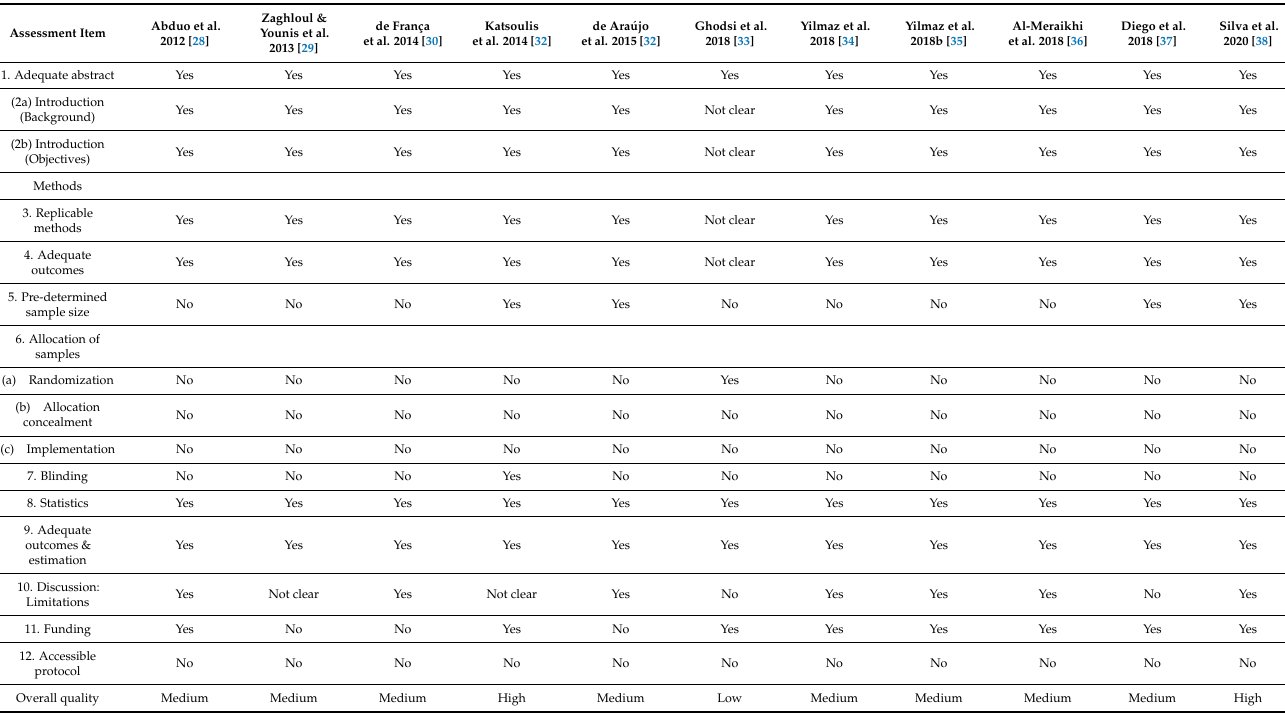
Table 3. Results of the quality assessment conducted on the studies included in this